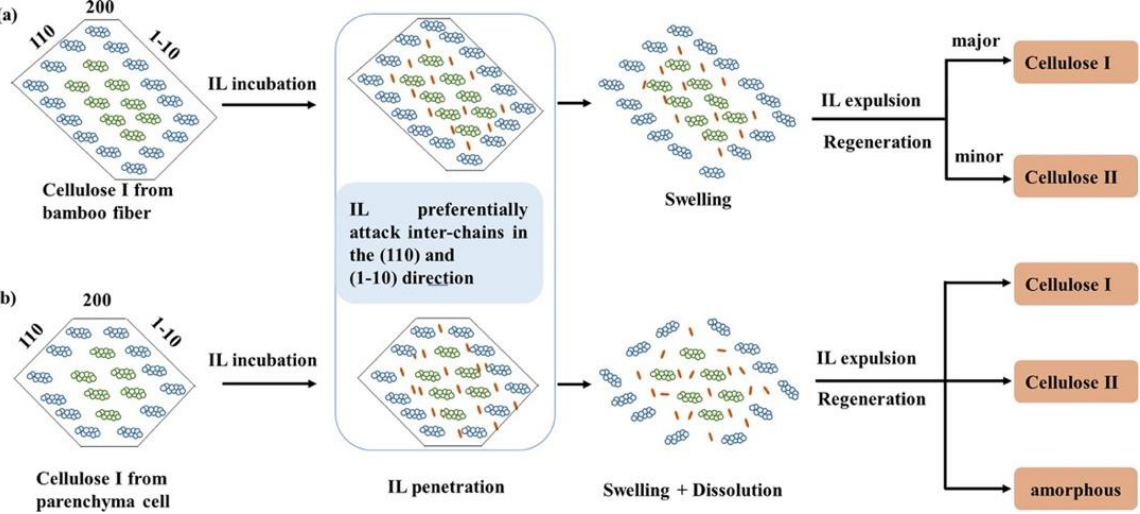
Figure 3. A probable scenario of the behavior under IL pretreatment of cellulose from bamboo fibers ( a ) and parenchyma cells ( b ). Initially, IL penetrated the spaces between chains in the direction of the (110) and (1 1 ̅ 0) planes, and caused the formation of disordered cellulose upon further treatment in IL. After expulsion of the IL with water, the cellulose chains recrystallized to cellulose II, cellulose I, or amorphous, depending on the severity of the IL treatment (reprinted with permission from [27]. Copyright © 2022, American Chemical Society).